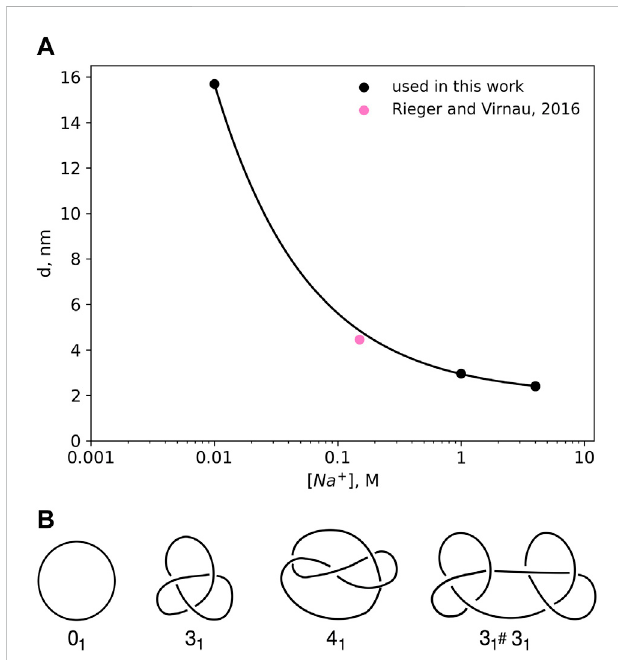
FIGURE 1 (A) EffectivediameterofDNA, d asafunctionofNaClconcentration as calculated by Stigter (1977) on the basis of polyelectrolyte theory. The valuesfortheeffectivediameter, d havebeenobtainedbycalculatingthe interaction potentials of highly charged colloidal cylinders representing DNA. The effective diameter value for physiological salt concentrations 0.15 M has been taken from Rieger and Virnau (2016). (B) Knot types considered in this